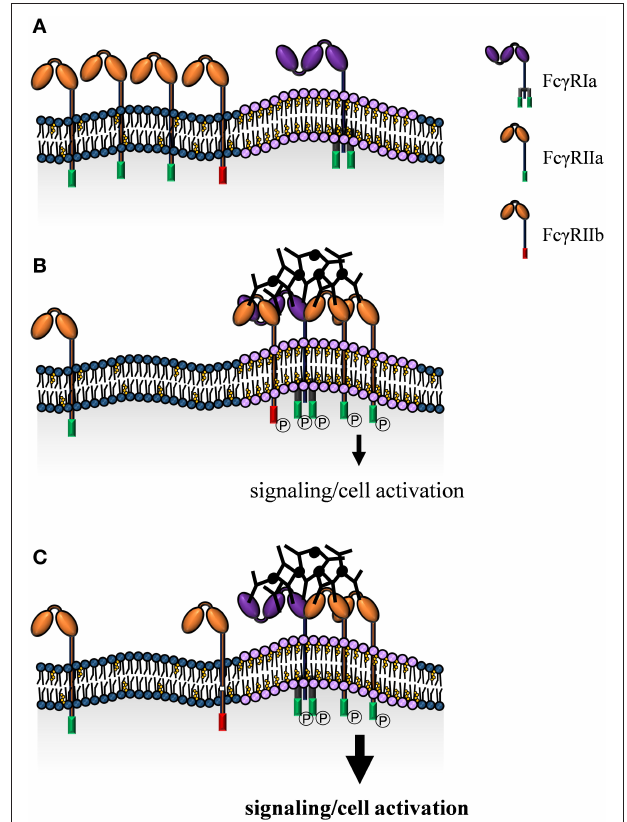
FIGURE 3 | Model of Fc γ R localization and receptor clustering in the cell membrane. Classical monocytes express the activating Fc γ RIa and Fc γ RIIa and the inhibitory Fc γ RIIb with distinct membrane localizations. Fc γ RIa is predominantly confined to cholesterol-rich lipid raft domains, while Fc γ RIIa and Fc γ RIIb are found in non-raft regions in absence of IgG immune complexes (A) . Upon IgG immune complex binding Fc γ RIIa/b are recruited to lipid rafts. Close proximity to each other and to signaling components concentrated at lipid raft domains, enables ITAM/ITIM phosphorylation and induction of intracellular signaling cascades (B) . Exclusion of Fc γ RIIb from lipid rafts due to a mutation in the transmembrane domain causes enhanced activatory signaling (C)